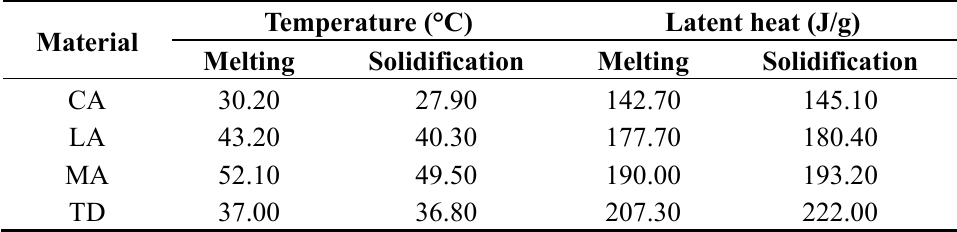
Table 1. Properties of latent heat storage